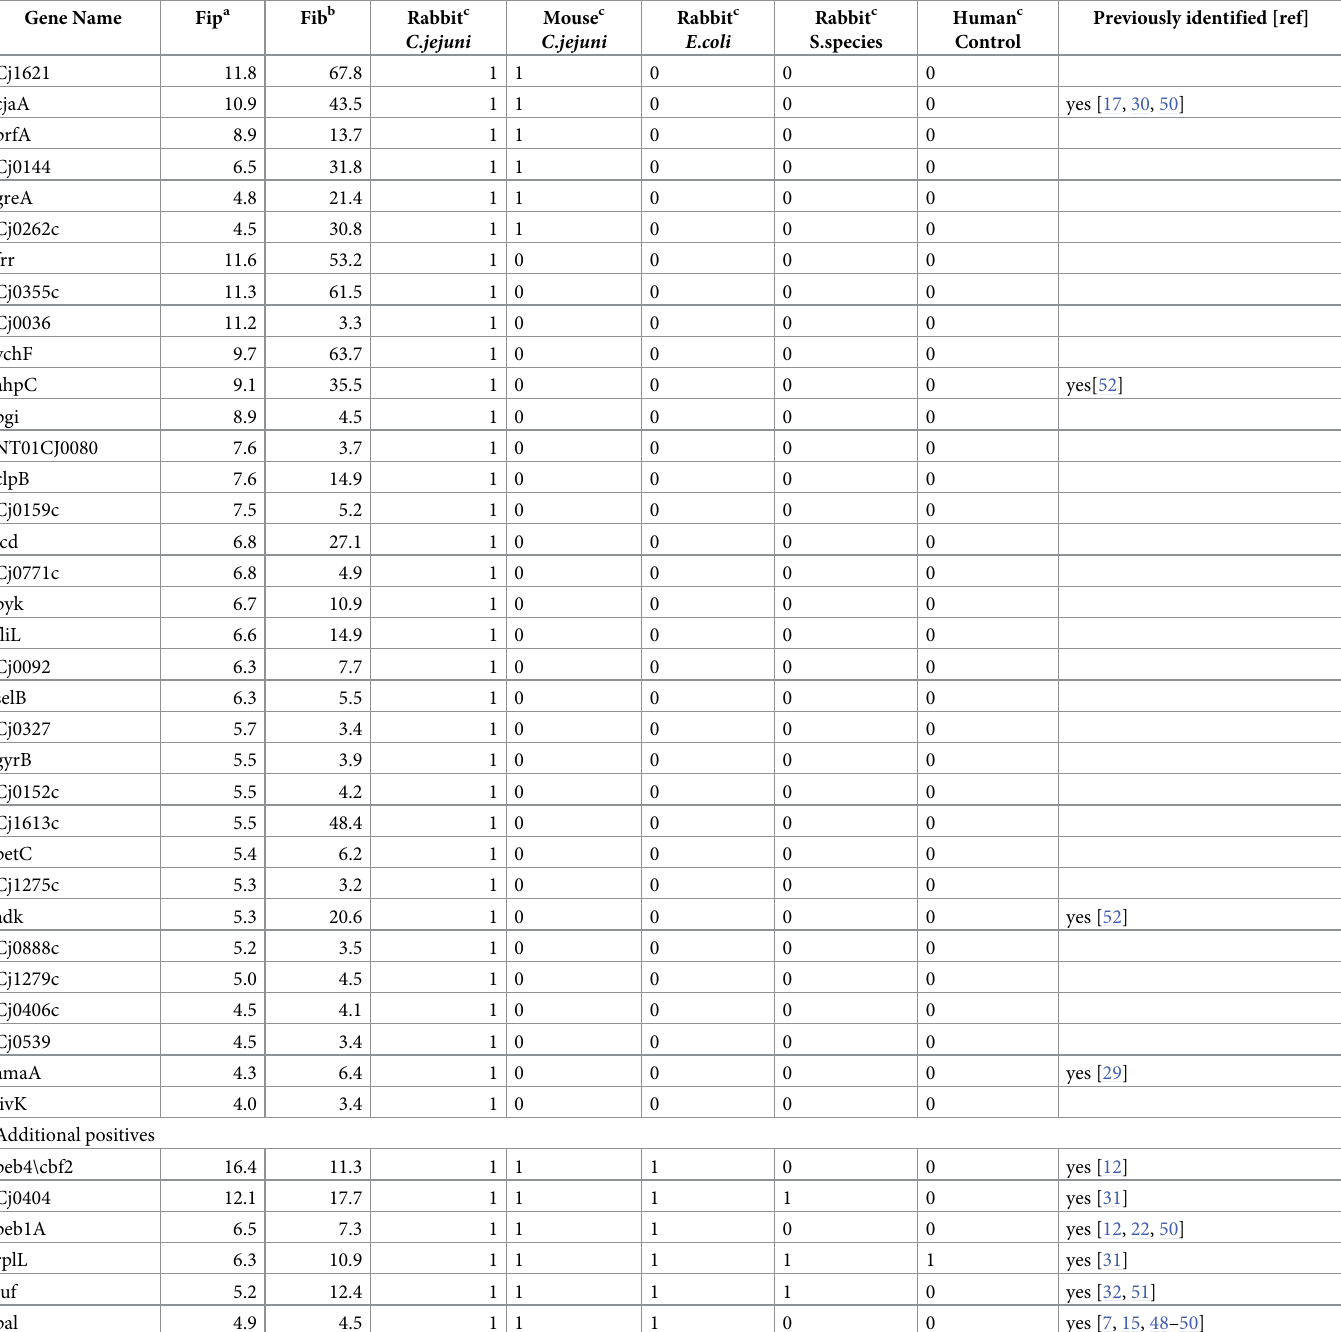
Table 1. Specific C . jejuni antigens identified on the